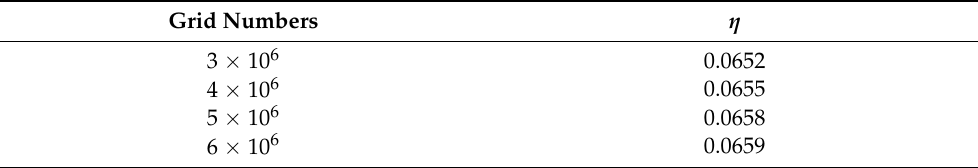
Table 3. Average cooling effectiveness for different grid numbers.